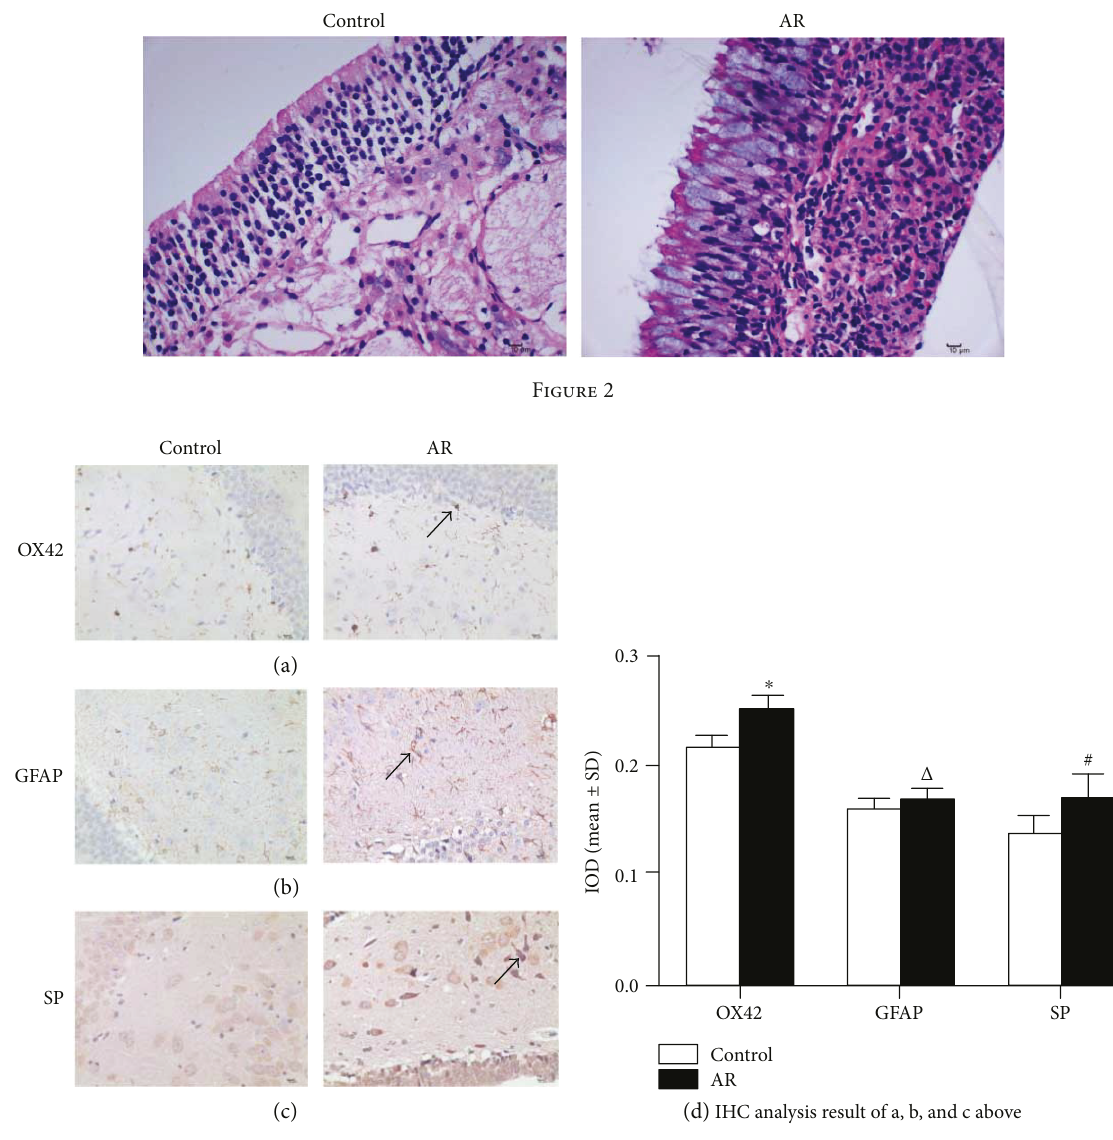
Figure 3: Representative photographs indicating IHC analysis ( × 400). Expression of (a) CD11b (OX42-stained), (b) GFAP, and (c) SP. (d) shows statistical analysis of the results. Data are expressed as mean ± SD; ∗ P < 0 01 , △ P < 0 05 , # P < 0 01 ; n = 8 ; scale bar =50 μ